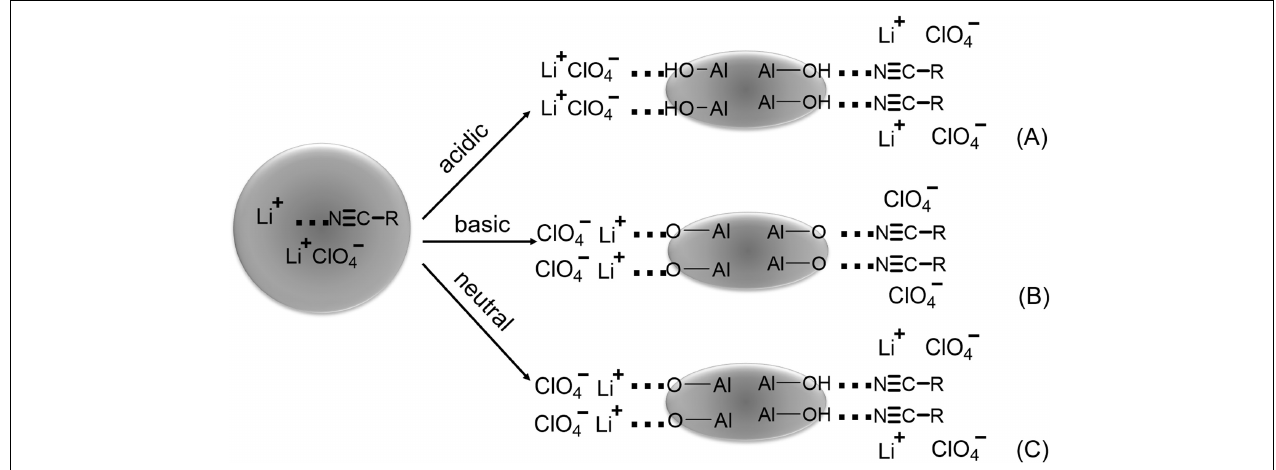
FIGURE 2 | Schematic demonstration of the Lewis acid-base dissociation effects of (A) Lewis acidic, (B) Lewis basic, and (C) neutral surface groups on ionic conductivity. Reprinted with permission from reference Wang et al. (2003). Copyright 2003 The Electrochemical Society, Inc.